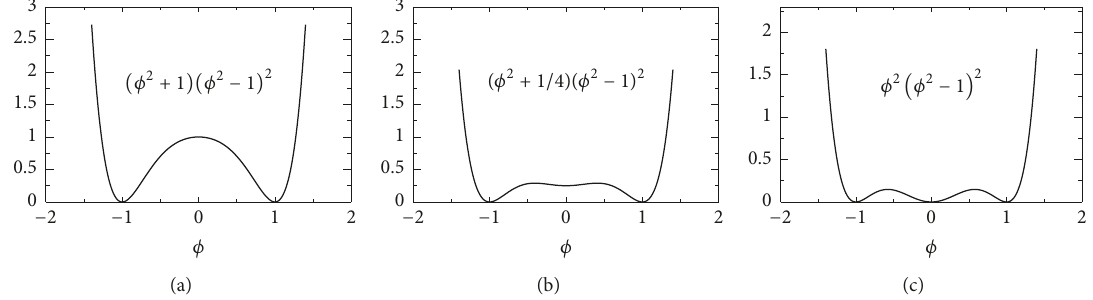
Figure 1: The field potential (see (2)) in the 𝜙 6 model for various values of the real parameter 𝑎 = 1, 1/2, 0 from (a) to (c).